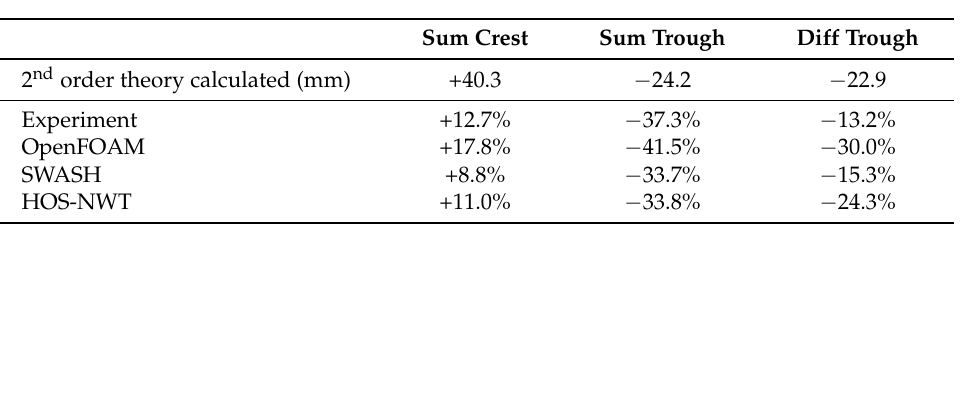
Table A1. Comparison between the extracted 2 nd sum and diff harmonics with 2 nd order theory solution using the evolved extracted linear amplitude spectrum at